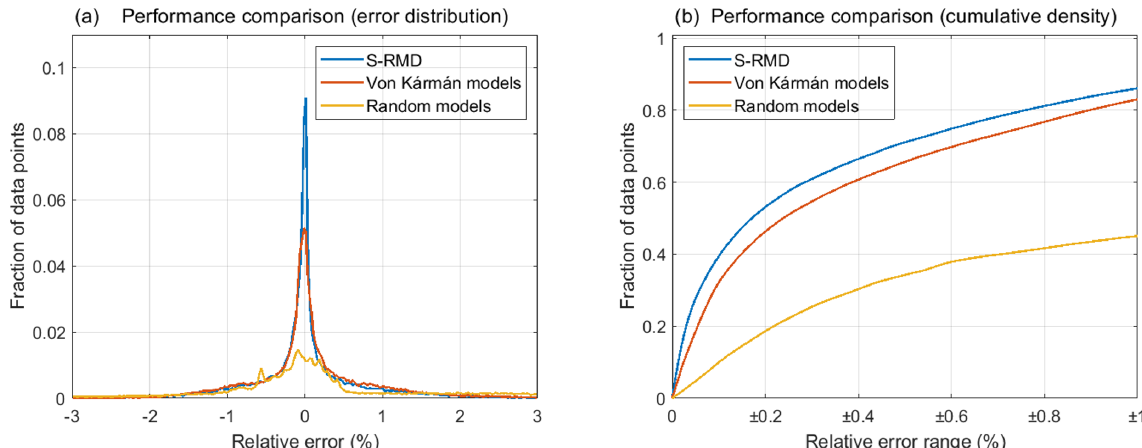
Figure 3. Performance of the networks trained on S-RMD, von Kármán models, and random resistivity models. (a) RL P distribution. (b) Cumulative distribution of RL P